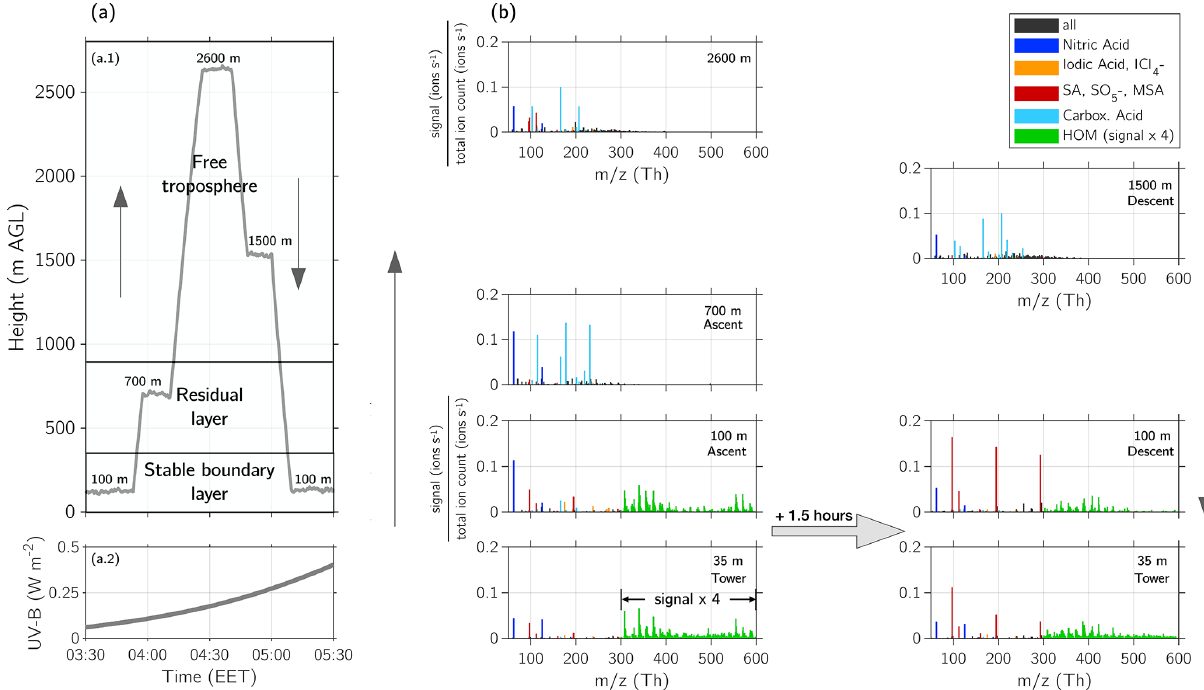
Figure 10. Measurements from the night flight on 16 May 2017. Height profile between 03:30–05:30EET in the morning (a.1) as well as UV-B radiation measured on the ground (a.2) . (b) Mass spectra during ascent as well as measurements from the tower; the height levels are indicated in each panel. The layers of the BL with estimation of SBL and RL are indicated in the height profile of panel (a.1) . The time difference between the measured mass spectra inside the stable layer at 100m is 1.5h. With upcoming sunlight, the sulfuric acid clusters become the most abundant peaks in the